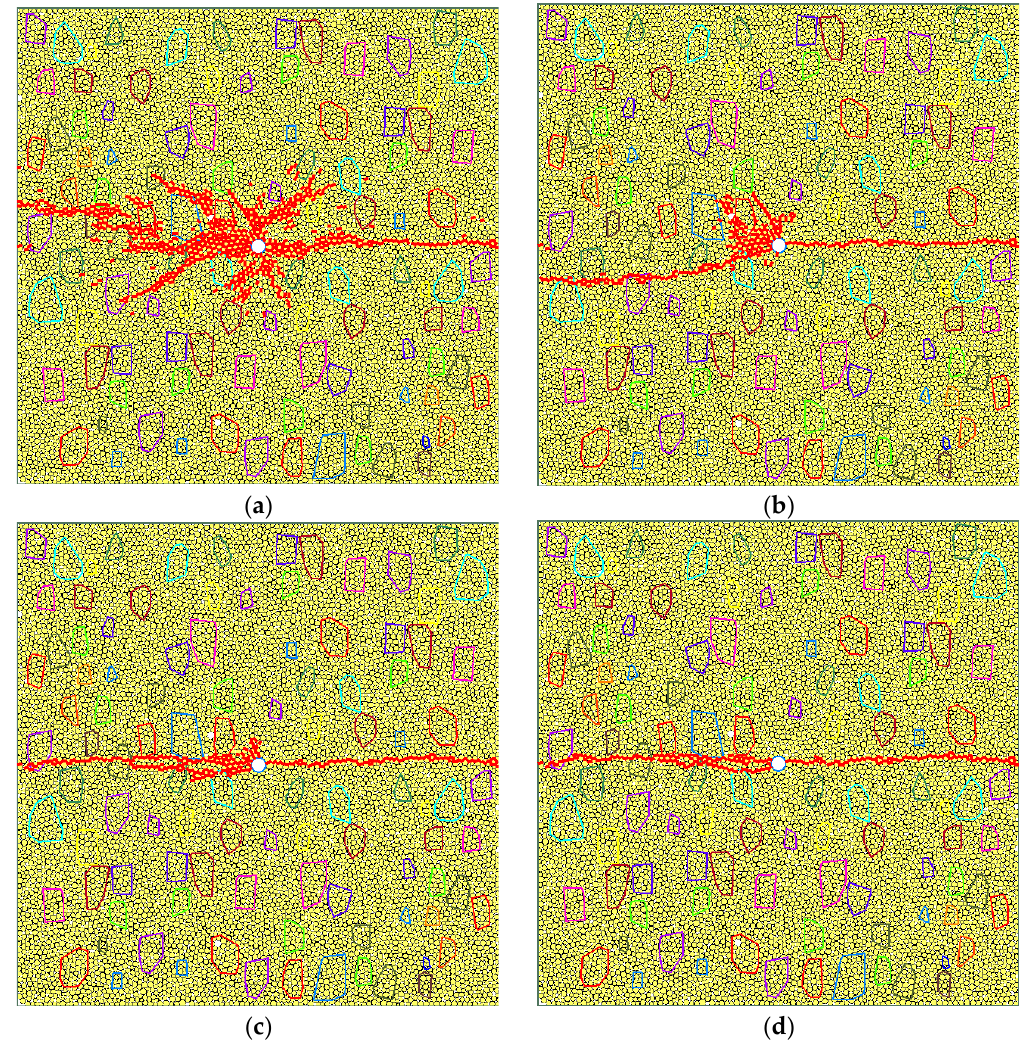
Figure 5. The fracture morphologies under different permeabilities. ( a ) k = 0.0005 × 10 − 3 μ m 2 . ( b ) k =